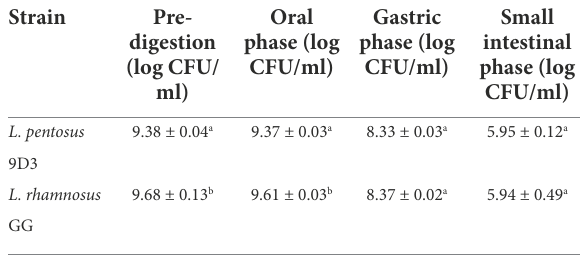
TABLE 4 Survival of L. pentosus 9D3 after in vitro digestion.